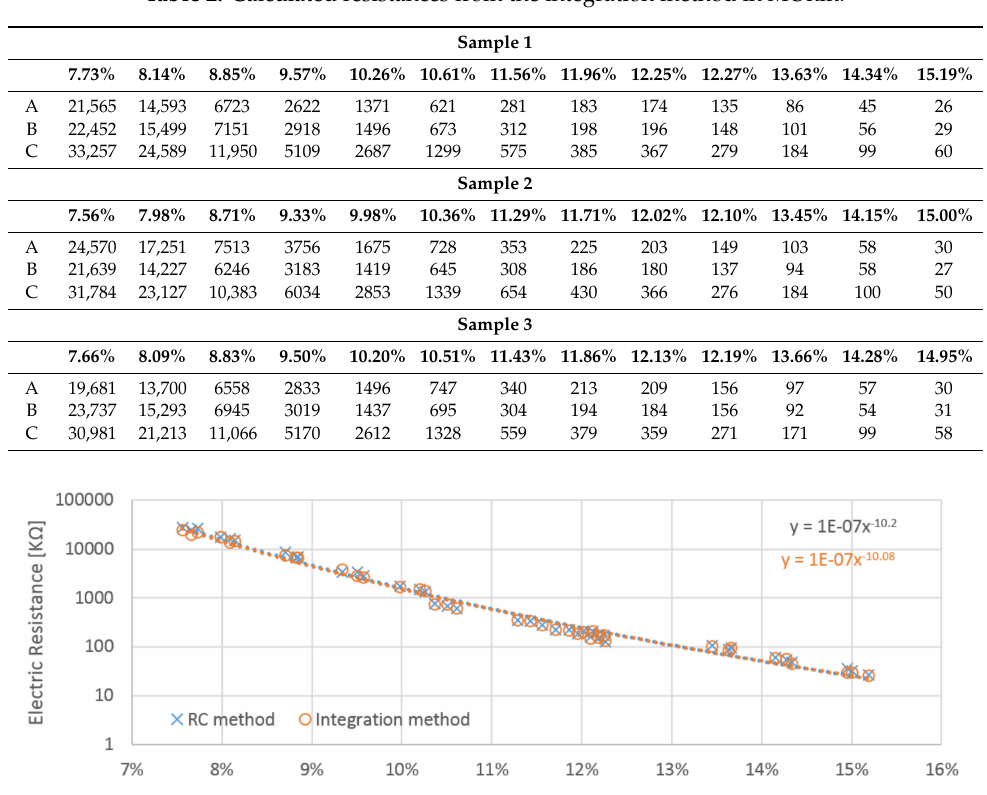
Figure 10. Obtained resistances from the integration and RC methods, the results calculated for the tops of the samples at the “A” electrodes.